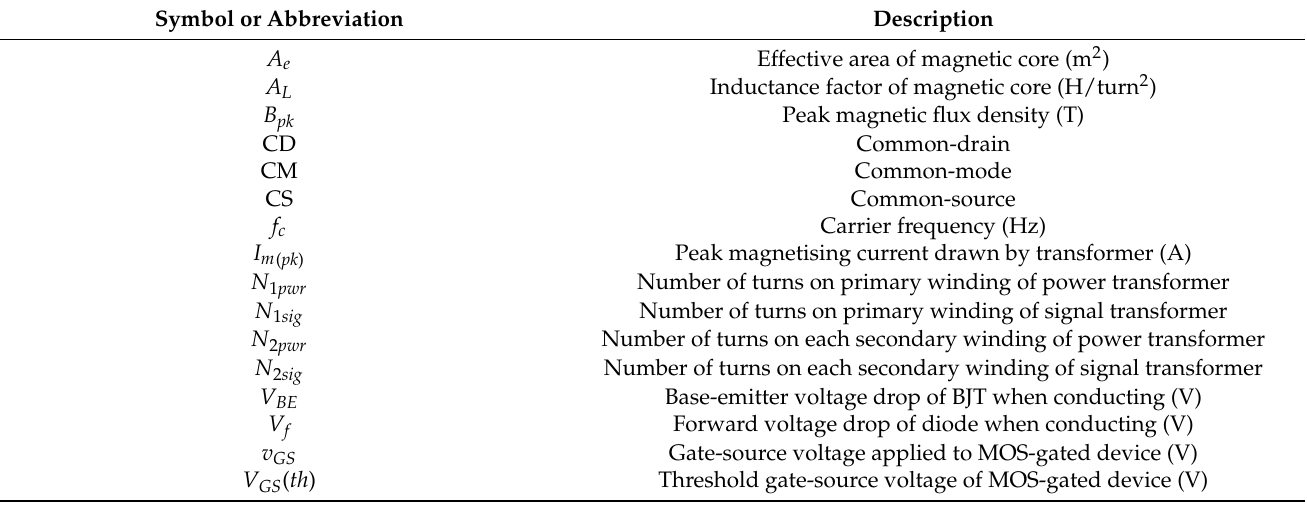
Table 1. Principle symbols and abbreviations.